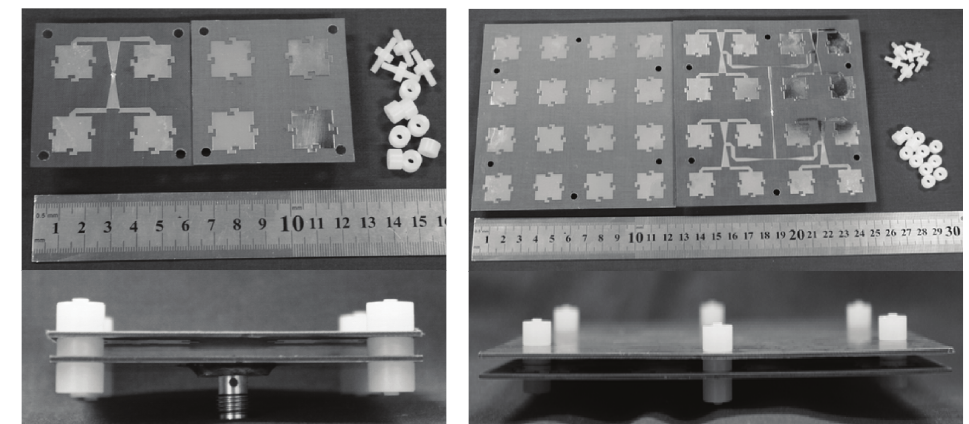
Figure 13: The both layers of the fabricated prototype antennas.